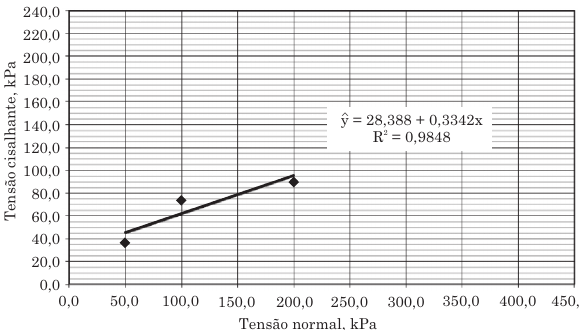
Figura 4. Envoltória de ruptura do talude sem plantio do capim vetiver.